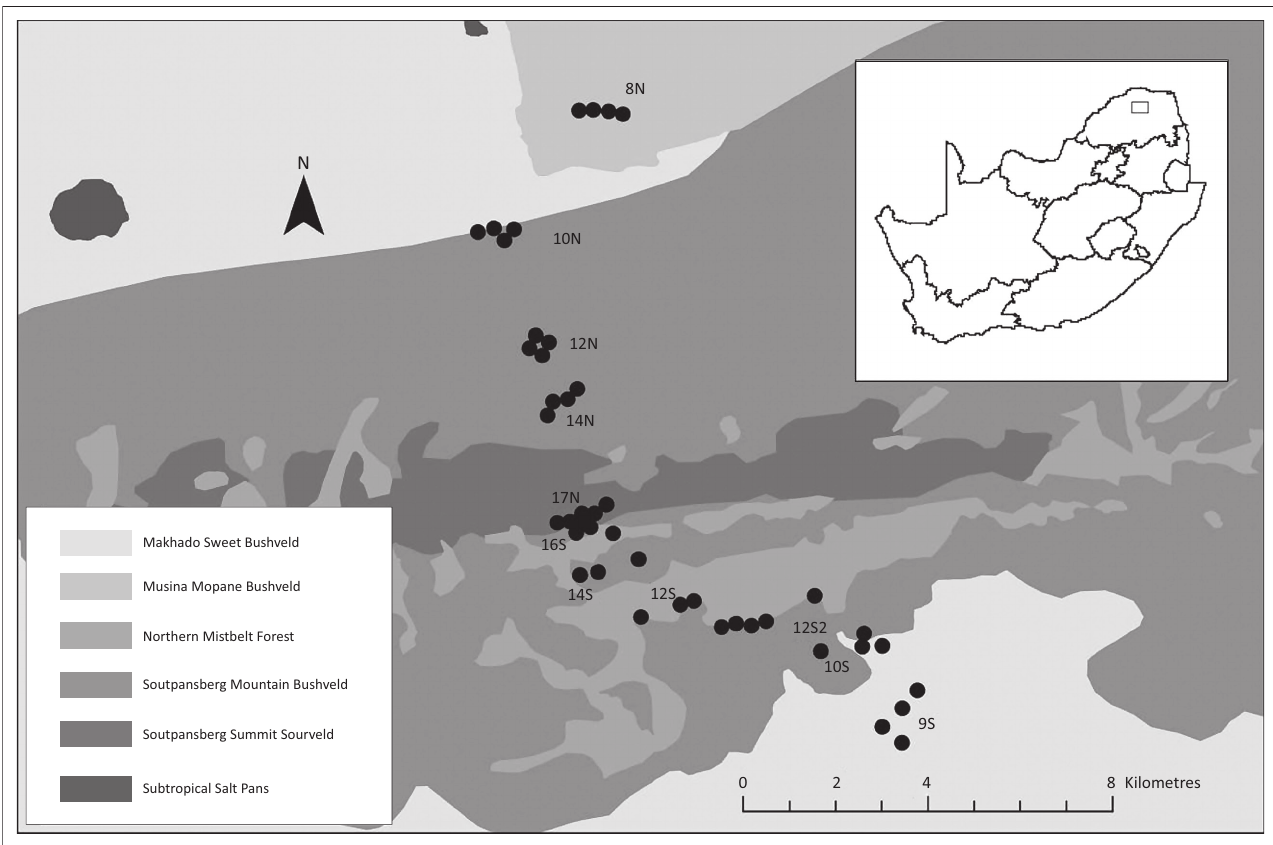
FIGURE 1: Location of the Soutpansberg transect in South Africa (inset) and the position of the 44 replicates with the 5 structural habitat types.